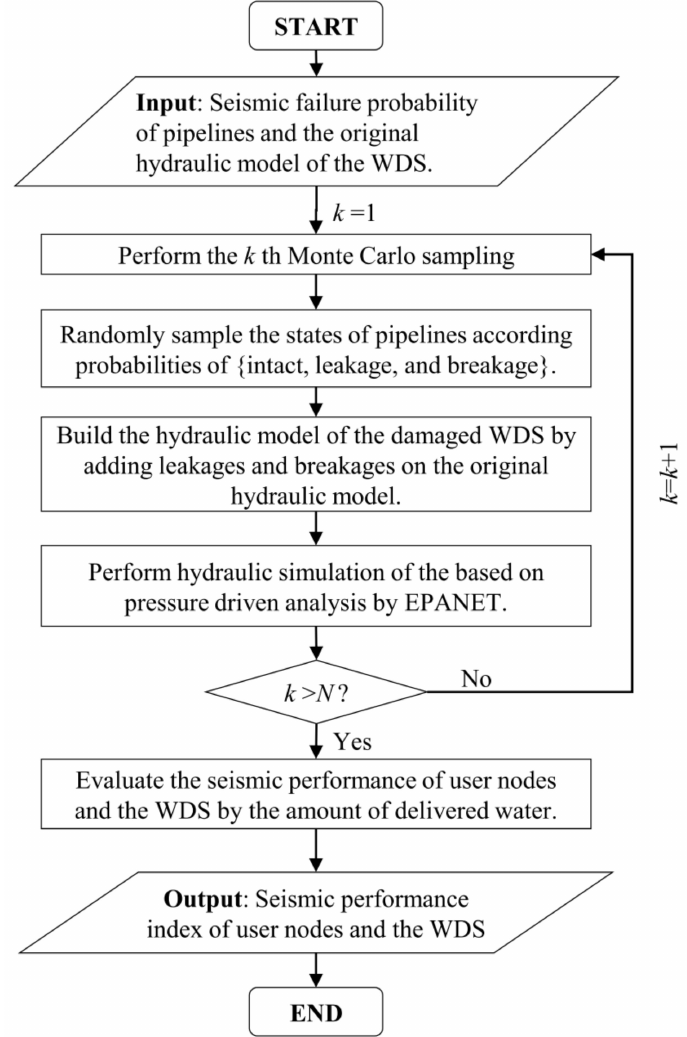
Figure 6. Flowchart of probabilistic seismic performance analysis of WDS based on